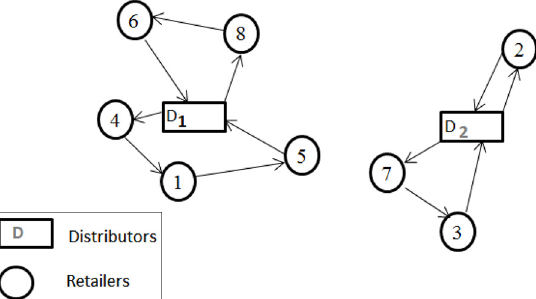
Figure 3. Mutation operation for each